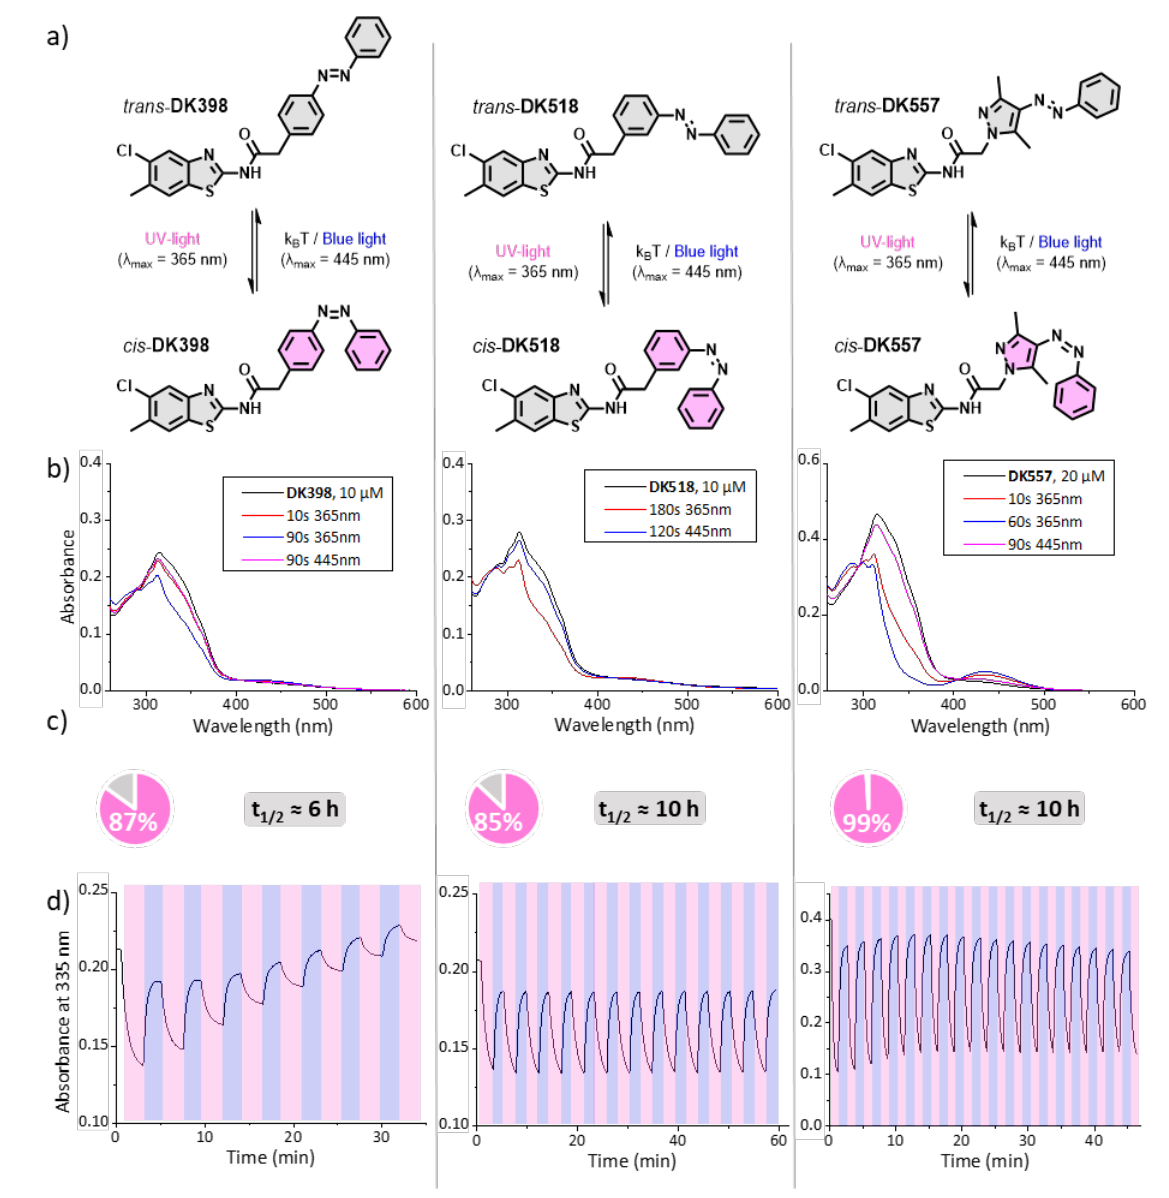
Figure 2. ( a ) Structures and irradiation-dependent interconversion of the trans and cis isomers of DK398 , DK518 , and DK557 ; ( b ) UV-Vis absorption spectra of DK398 , DK518 , and DK557 in kinase assay buffer (10 – 20 µM, 4.8% DMSO) in the thermally adapted (all trans ) and irradiated forms; ( c ) isomer distribution in the photostationary state (pie charts). The pink region represents the percentage of cis -isomer in the PSD as determined by 1 H-NMR (DMSO- d 6 ). The half-life for the thermal cis - to- trans isomerisation reaction (20 µM, kinase assay buffer, 1% DMSO, 35 °C) (Figure S4); ( d ) reversible switching cycles in kinase assay buffer containing DTT (0.5 mM) using UV light (λ max = 365 nm) and blue light (λ max = 445 nm).